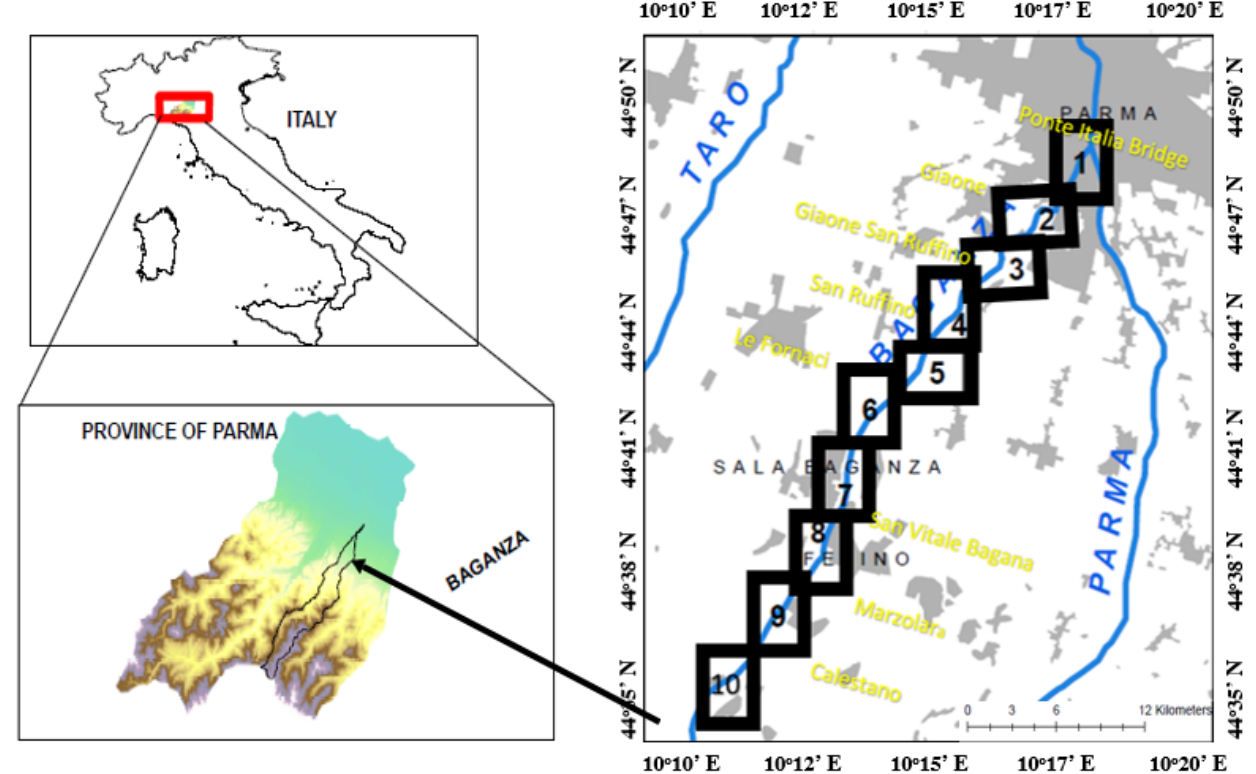
Figure 1. Geographical location map of the sediment sampling points along the Baganza River.